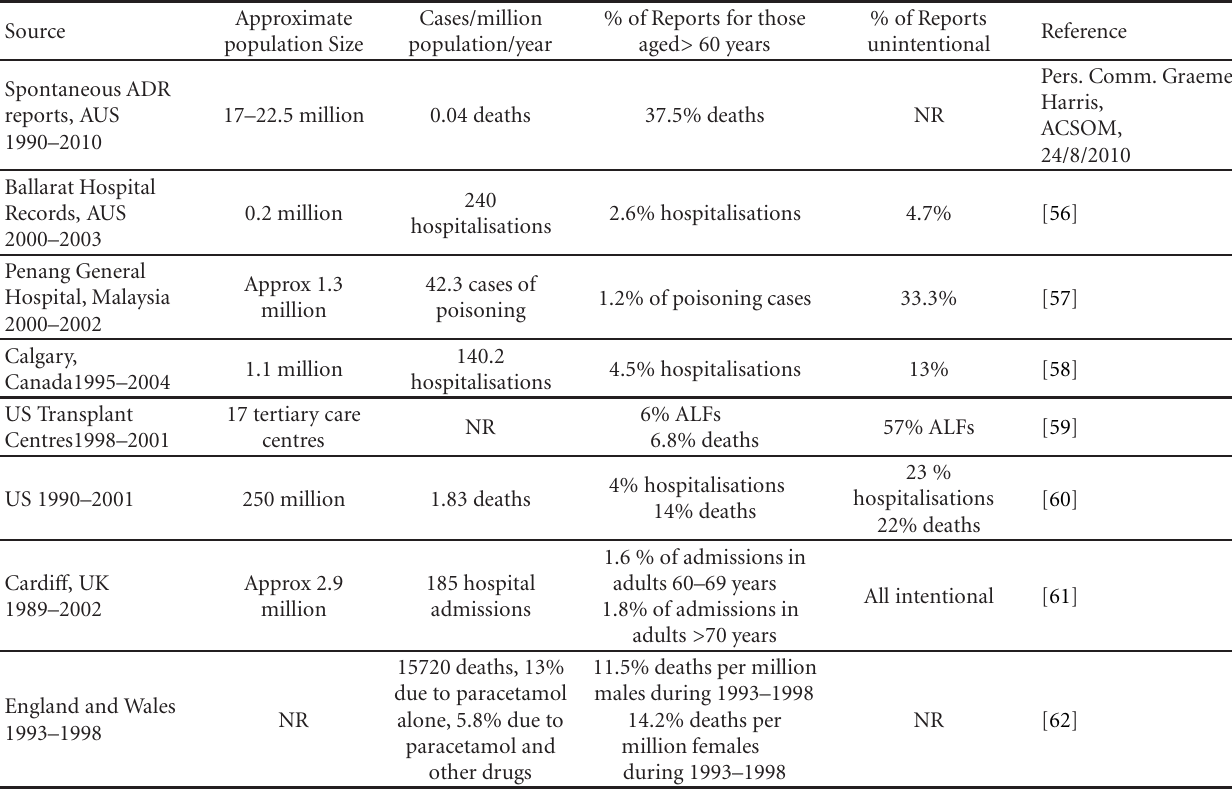
Table 3: Selected reports of paracetamol-related hepatotoxicity, deaths, and transplantsin the United States, Canada, United Kingdom, Malaysia, and Australia for the period 1989–2010. Only studies that have included a sub grouping for “older adults”, defined as those aged > 60 years, are